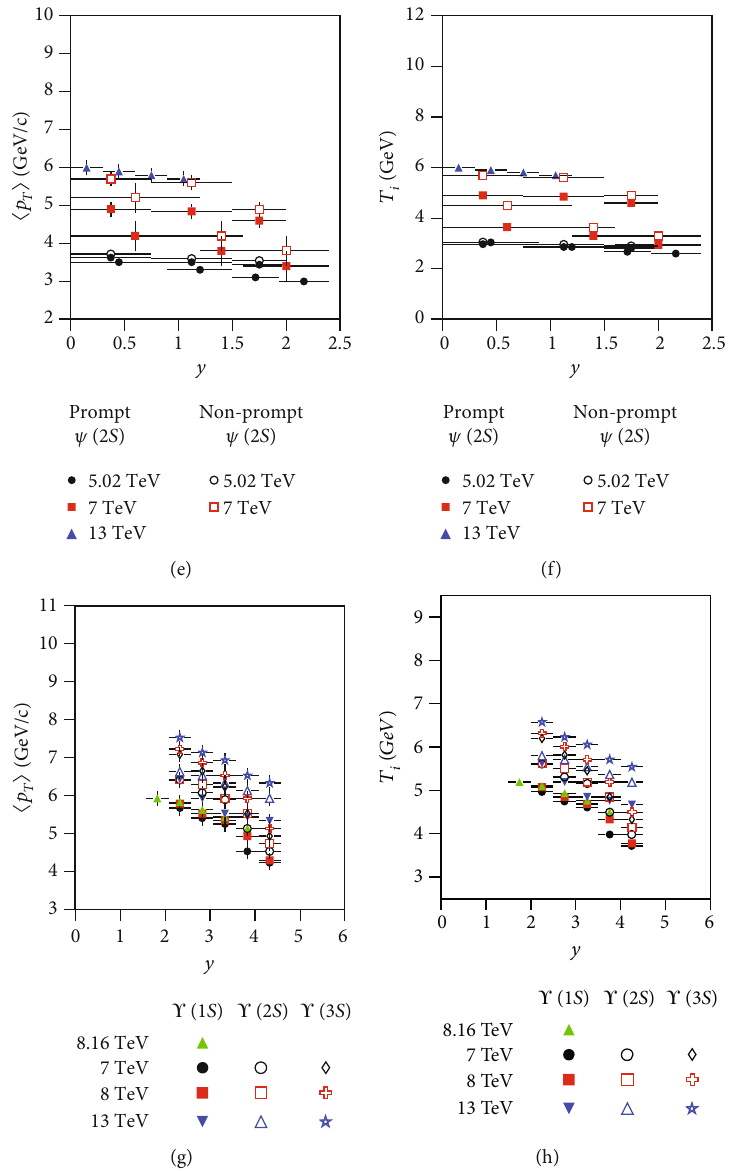
i and (b, d, f, and h) T C and (c – h) y for (a – d) i on (a, b) T